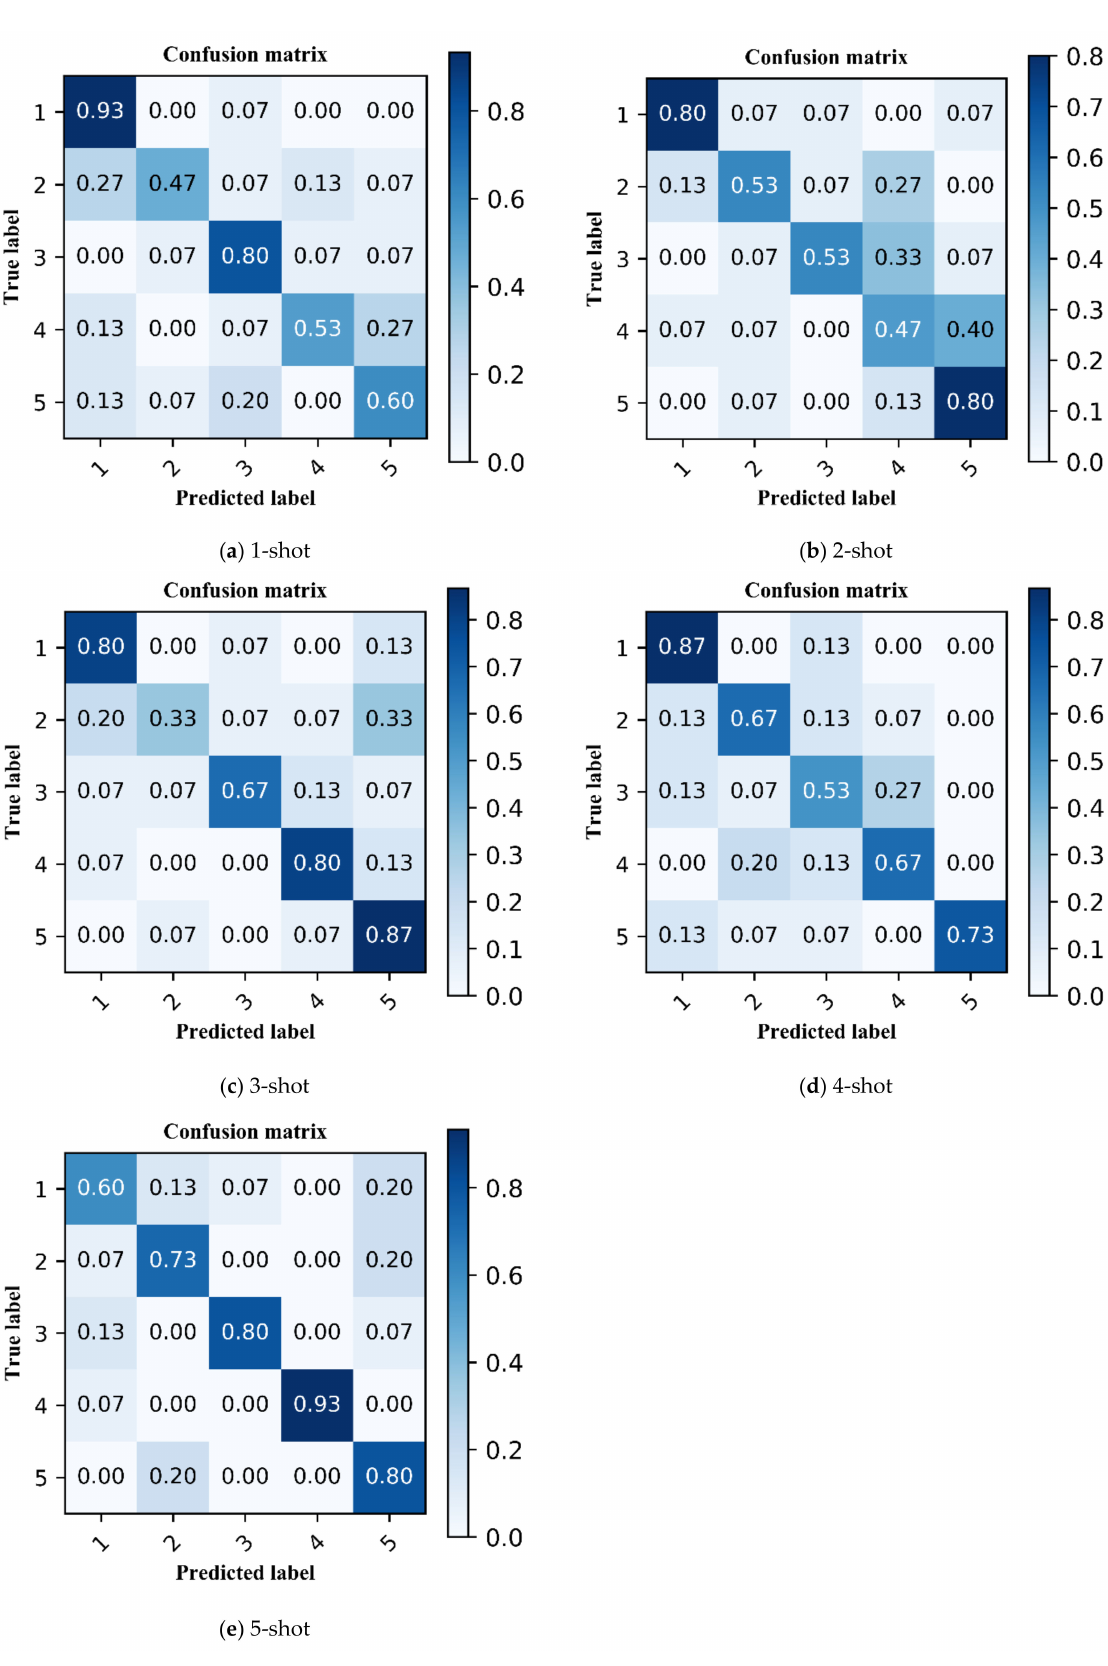
Figure 5. Confusion matrices of the proposed Meta-FSEO from 1-shot to 5-shot, where the entries in row i and column j represent the probability that the test image of category i is classified as category